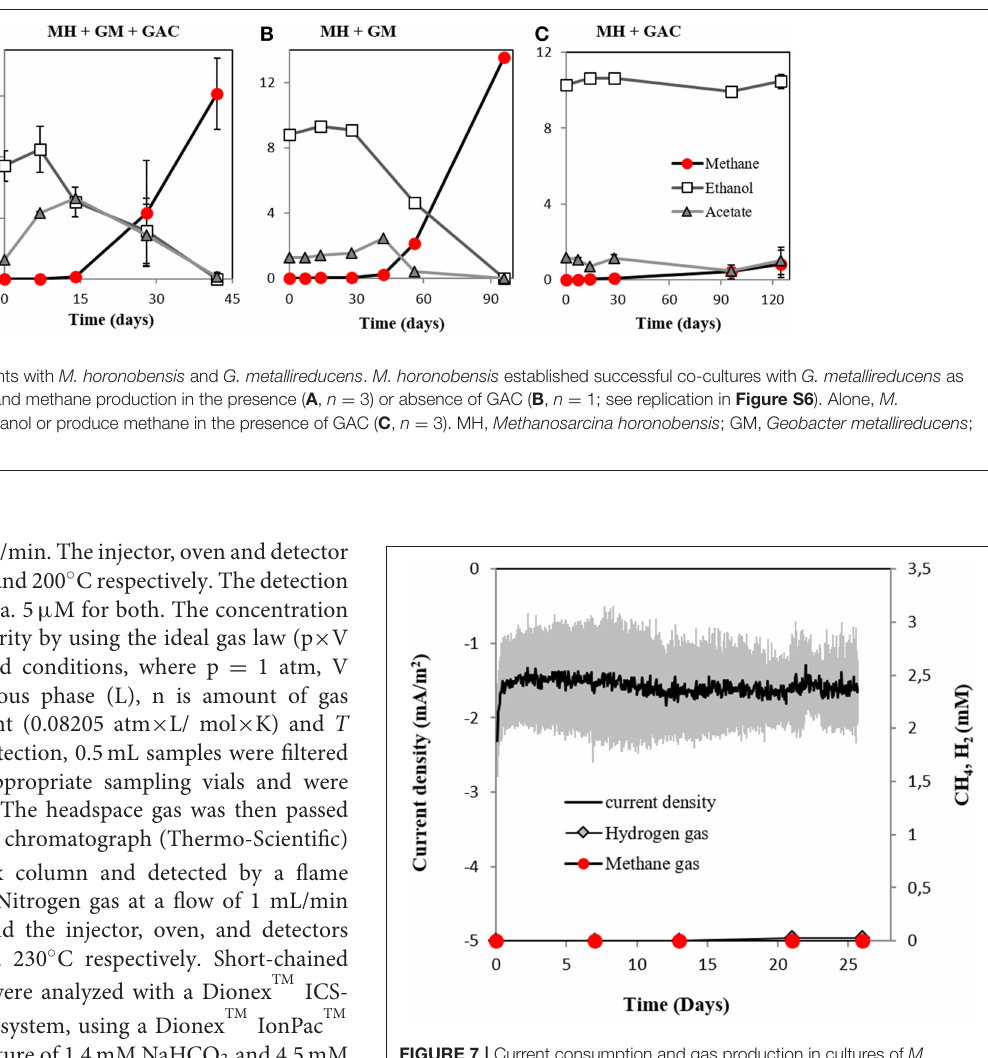
FIGURE 7 | Current consumption and gas production in cultures of M. horonobensis ( n = 3) provided with a cathode poised at − 400mV (vs. SHE) as sole electron